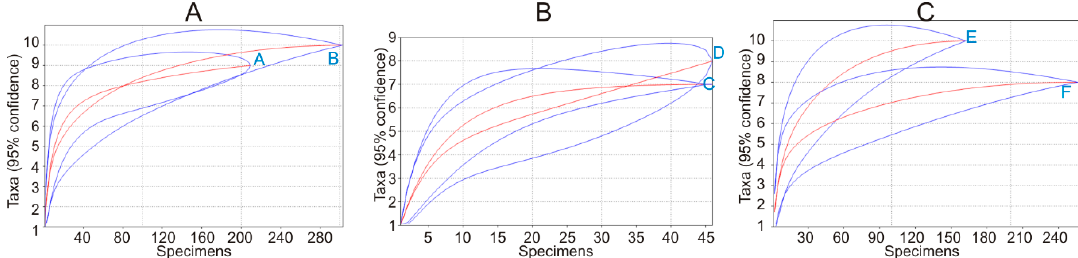
Figure A4. Control habitats at: ( a ) research site 1; ( b ) site 3; ( c ) site 5; ( d ) site 6; ( e ) site 8; and ( f ) at site 9.